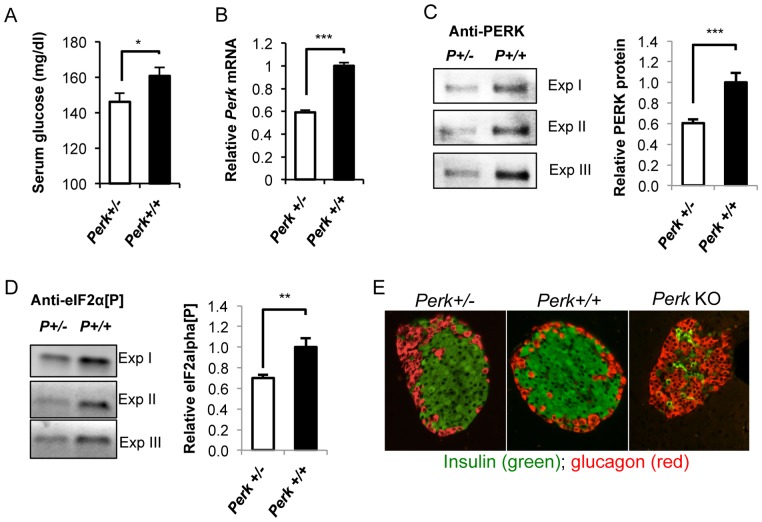
Modulation of Perk dosage using Perk+/− mice impacted glucose homeostasis.A. Random fed serum glucose of mice at 15–36 postnatal days. Mice are in mixed genetic background. Shown are means ± SEM (n = 44, 68; *P<0.05). B. Perk mRNA measurement in mouse islets expressed as percentage of Perk+/+ levels. Shown are means ± SEM (n = 29, 26; ***P<0.001). C. Western blot of PERK protein in mouse islets. Left panel showed representative blots. Right panel showed quantification of PERK protein levels in relative to Perk+/+. (n = 5, 5; ***P<0.001). D. Western blot of phosphorylated eIF2α in mouse islets. Left panel showed representative blots. Right panel showed quantification of PERK protein levels in relative to Perk+/+. (n = 5, 4; **P<0.01). E. Immuno-staining of pancreatic section from Perk+/−, Perk+/+, and Perk KO mice using insulin and glucagon antibody.